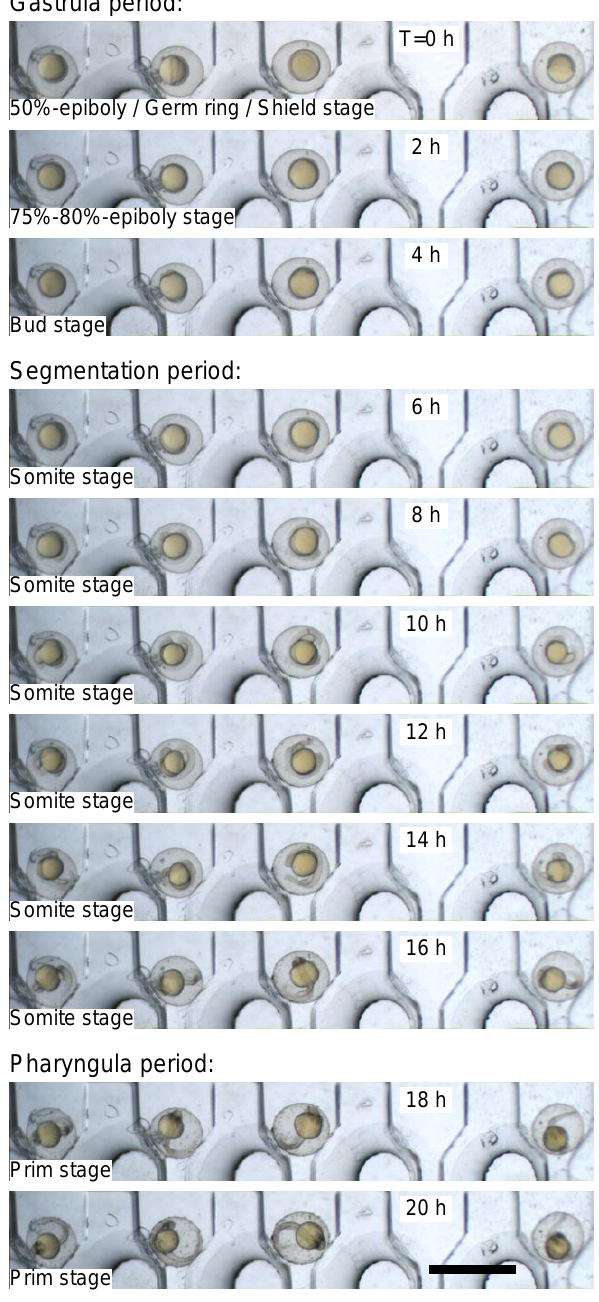
Figure 6. Twenty-hour live imaging of the early-stage development of zebrafish embryos immobilized in the microfluidic device. Scale bar: 2 mm.